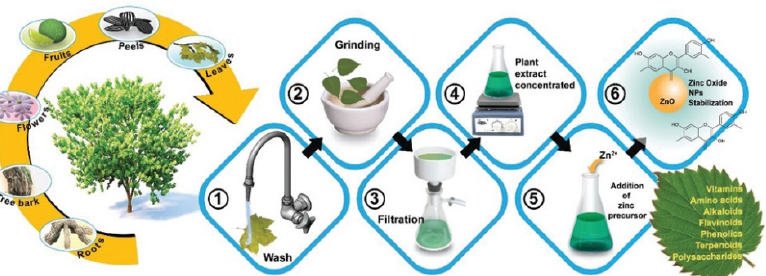
Figure 3. Schematic explanation of the phyto-mediated synthesis of ZnONPs. (1) washing, (2) grinding-milling, (3) filtration, (4) pre-concentration (facultative), (5,6) addition of zinc precursor and ZnONPs production. Wiley material reproduced from [15] with permission from John Wiley & Sons Inc, the Wiley Companies ® .